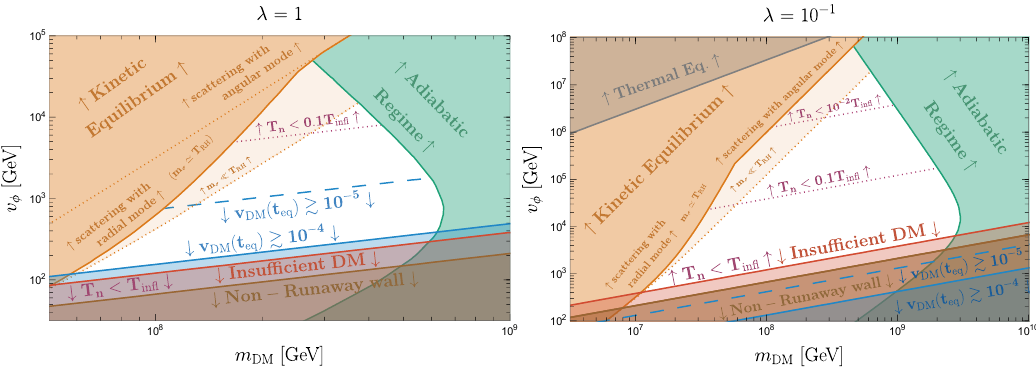
Figure 8: Heavy non-cold DM from fast bubble walls in the plane of v φ vs DM mass < T m , for T . The heavy DM is efficiently produced by fast bubble walls (outside n infl DM of the green area), compatible with Lyman- α bound (outside of the blue area - here > 3 keV), and kinetically decoupled from the bath (outside of the orange taking m WDM area). Bounds from kinetic equilibration via scatterings of DM with light radial and angular modes σ and a , Eqs. (C.23) and (C.30), have also been indicated. Future 21-cm reach is shown with a dashed blue line. Amount of supercooling is shown with dotted purple lines. At fixed DM abundance, the decrease of the DM-scalar mixing λ (from left to right) leads to an increase of the phase transition scale v φ which implies a longer redshift of the DM momentum, and results in colder DM. In red, the yield Y DM in Eq. (9) is insufficient to explain DM. In brown, the Bodeker&Moore criterium [ 37 ] > Λ is satisfied and the acceleration of bubble walls is stopped by thermal vac P LO = 20 and c = 0.01). In gray (right panel), the reheating friction (we chose g a vac > T temperature is larger than the DM freeze-out temperature T and DM goes RH FO back into thermal equilibrium (we assumed the maximal annihilation cross-section allowed by